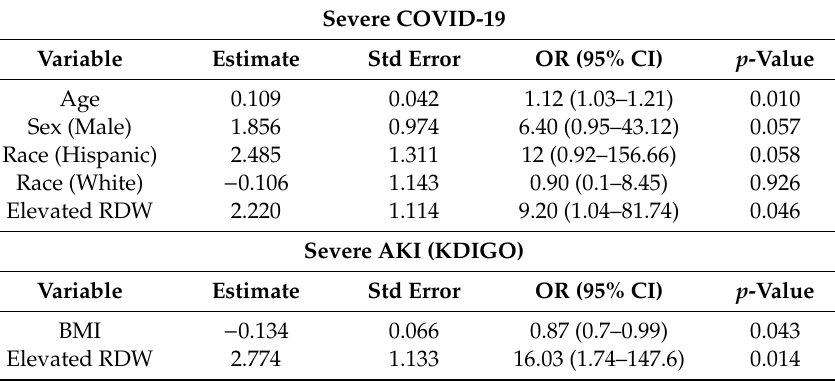
Table 3. Results of multivariable logistic regression for RDW prediction of severe form of COVID-19 and